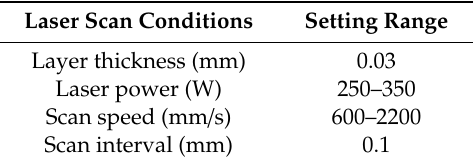
Table 1. Laser scan conditions in the present study.